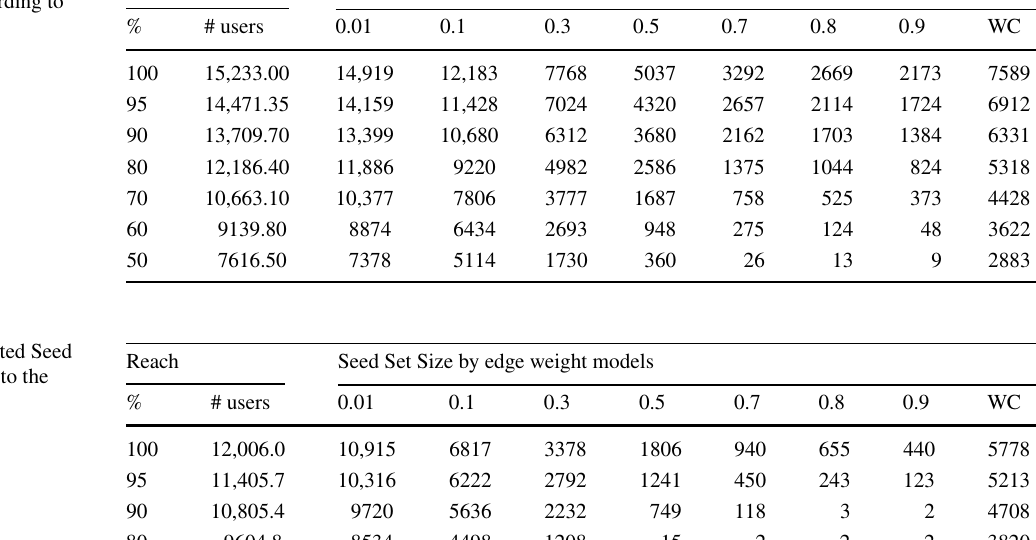
Table 5 Nethept expected Seed Set Sizes k ∗ p according to the reach